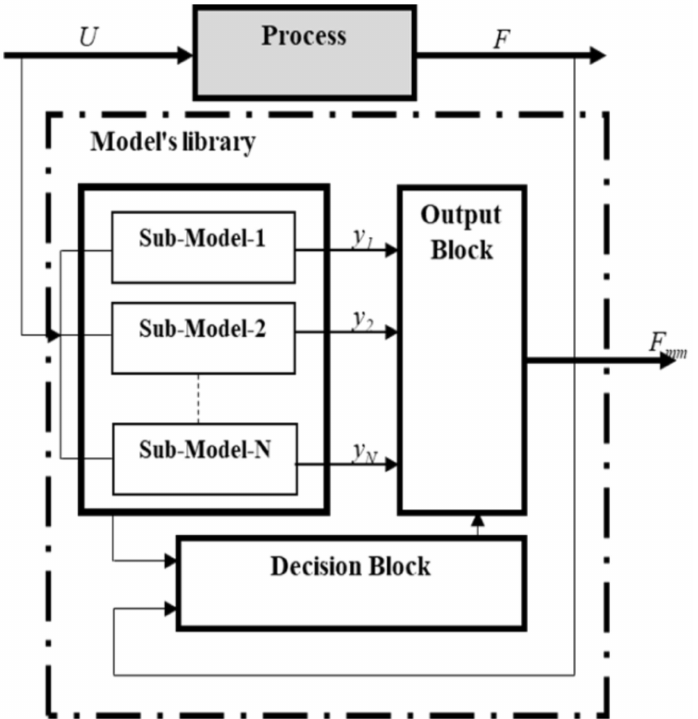
Figure 1. Magnetisation principal of multimodel approach.